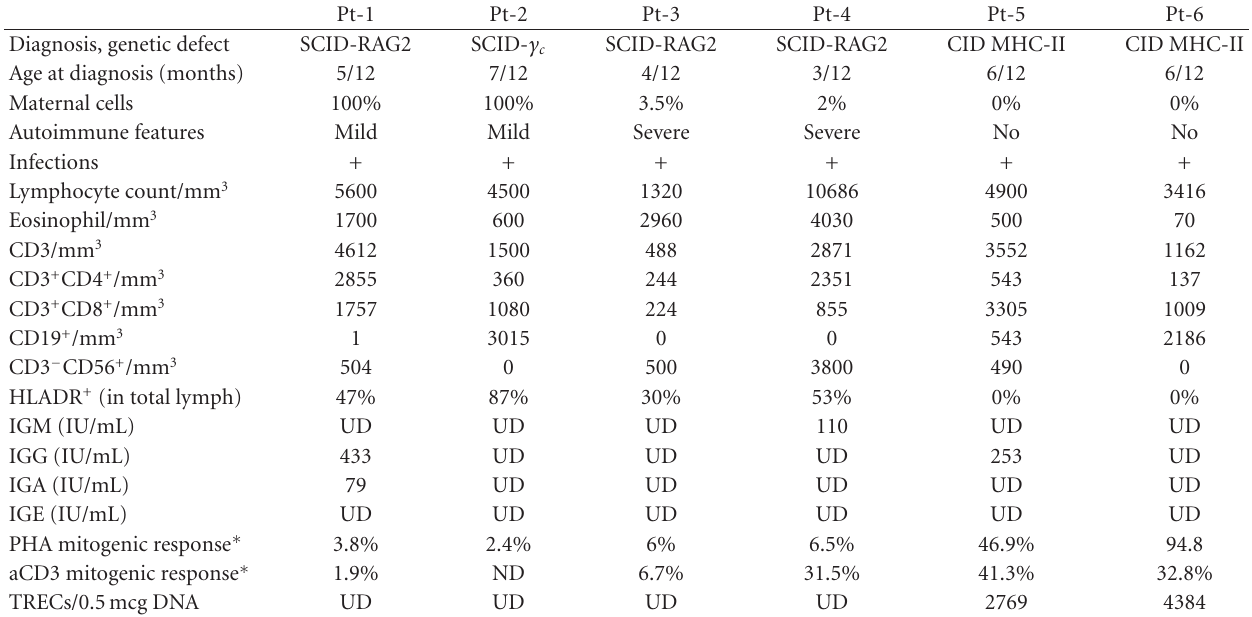
Table 1: Clinical and immunological findings in 6 patients diagnosed with